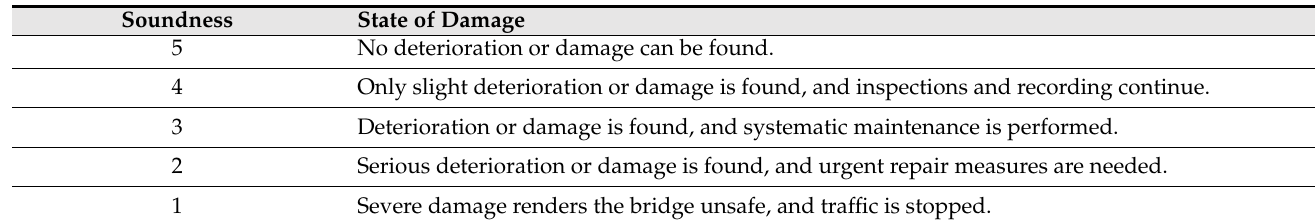
Table 1. Soundness Evaluation Standards for Bridges in Ishikawa